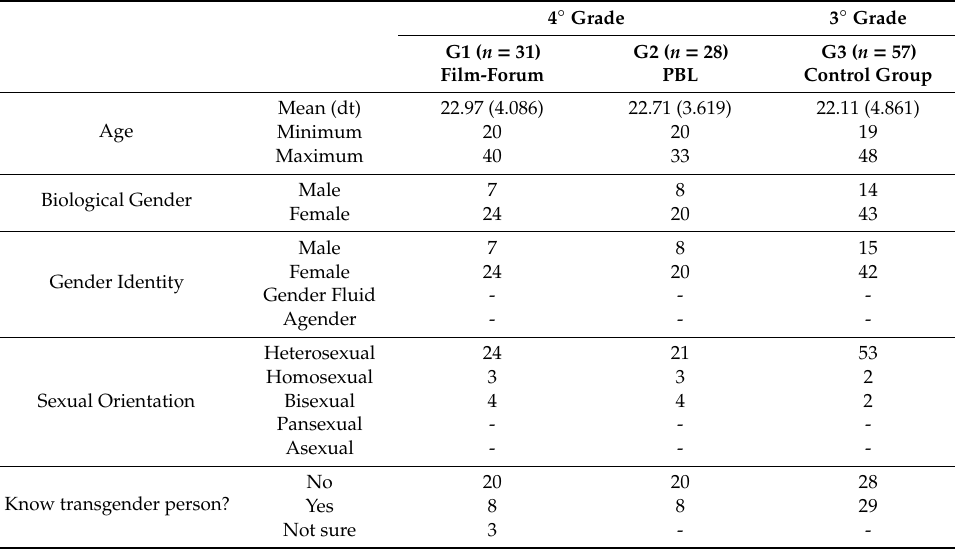
Figure 2. Kruskal–Wallis test. Grouping variable: Group. Table 1. Variables and